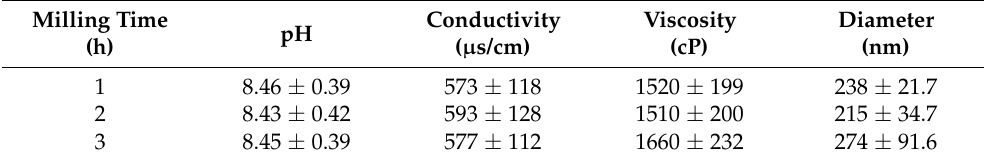
Table 1. pH, viscosity, conductivity, and diameter measured for CB dispersions prepared with SMA-1000 after storing 11 days.